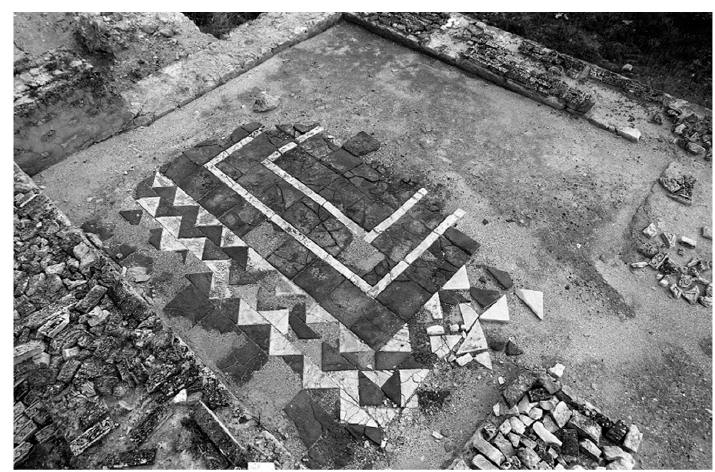
Figure 5. Floor in D ā r al-Mulk . (Photo A. Vallejo © Conjunto Arqueológico de Madinat al-Zahra).